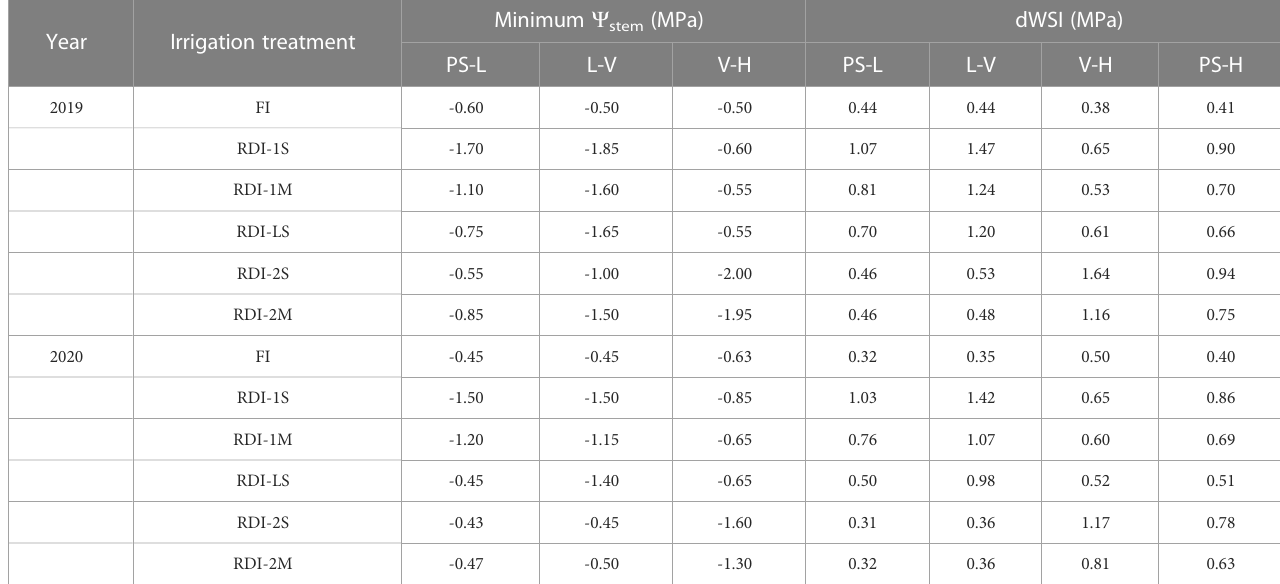
TABLE 1 Minimum stem water potential ( Y stem ) and daily water stress integral (dWSI) of Sangiovese grapevines ( Vitis vinifera L.) measured in 2019 and 2020 from berry pea size to lag phase (PS-L), from lag phase to beginning of veraison (L-V), from beginning of veraison to harvest (V-H), and from pea size to harvest